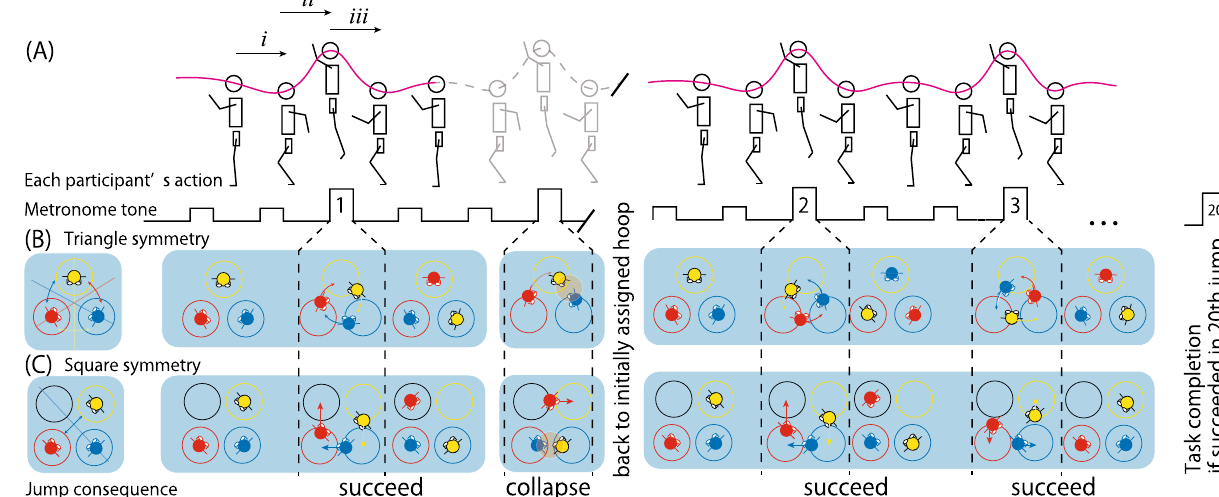
Figure 1. Triadic jumping task performed in the real and virtual spaces. ( A ) Jumping timing and jumper’s action sequence. All three jumpers are cued every 3 s by a high-pitched metronome tone following two low tones, as shown in the pulse diagram. The jumpers prepare for the high-pitched metronome tone by swinging their arms backward and bending their knees, as shown in phase i . Then, they swing their arms forward and upward and jump using ground reaction force earned during the movement in phase i , indicated as phase ii , followed by touch down phase iii . During these preparatory and jumping phases, the participants’ vertical head position fluctuates along with trajectory indicated in magenta. ( B ) Initial hoop-jumper configuration in the triangle geometry with D 3 symmetry is shown in the left-hand side. Regular triangle configuration is retained ◦ ◦ ◦ even if the configuration is rotated by 0 (360) , 120 , or 240 , and if the configuration is reversed about any of the three axes (colored in red, blue, and yellow; also see Supplementary Information). ( C ) Initial hoop-jumper configuration and the following sequence of failed and succeeded jumps in the square condition. Symmetry ◦ of the initial hoop-jumper configuration (left) is D 1 such that it can only be rotated by 0 (360) and possesses only one reversing axis (colored in blue) to retain the initial hoop-jumper configuration. The jumping action sequence performed by three jumpers can be seen in the Supplementary Video